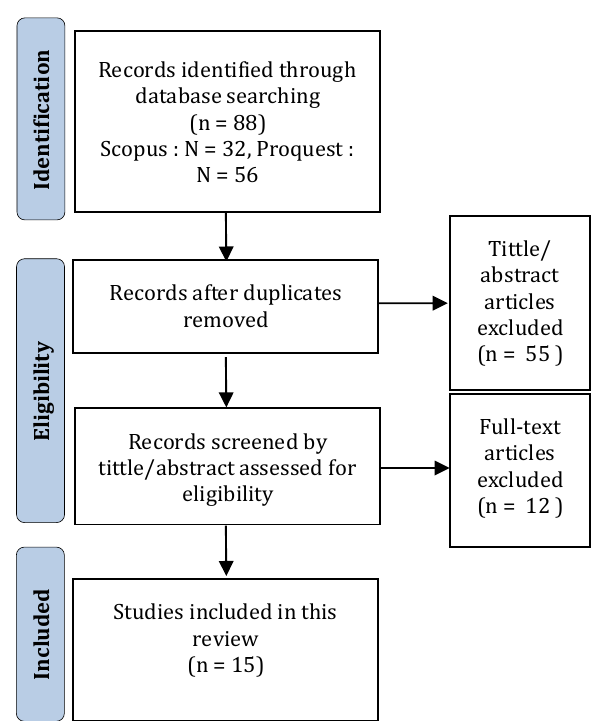
Figure 1. Result and Selection Procedure Characteristics of the 15 selected articles are different. Of the studies included in analysis, 6 were cross-sectional, 5 were cohort study, and